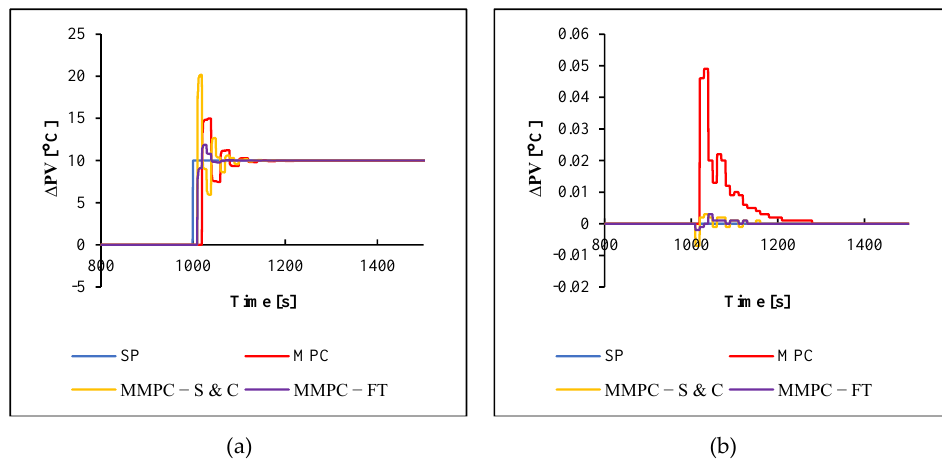
Figure 11. Comparison of the controller performance with SP change on the heater on: ( a ) the heater; and ( b ) the combustor. Table 15. Comparison of IAE and ISE on the heater and combustor units due to changes in SP on the heater unit.